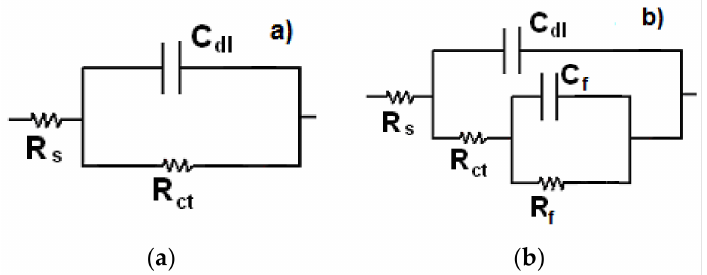
Figure 8. Electric circuits to simulate EIS data X-52 steel corroded in a CO 2 -saturated 3% NaCl solution ( a ) in absence and ( b ) presence of gemini surfactant.